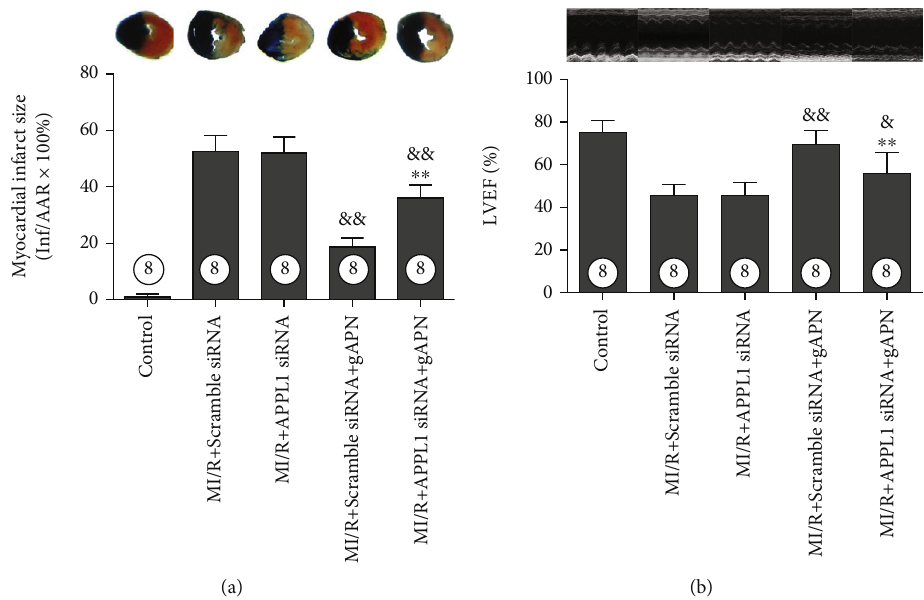
Figure 3: Cardiac speci fi c injection of APPL1 stealth RNAi blunted cardioprotective actions of APN against MI/R injury. (a) Myocardial infarct size. Determined by Evans blue/TTC double staining. (b) Cardiac function. Determined by echocardiography. ∗∗ P < 0 : 01 vs. the same treatment group without APPL1 siRNA. & P < 0 : 05 ; && P < 0 : 01 vs. the same treatment group without